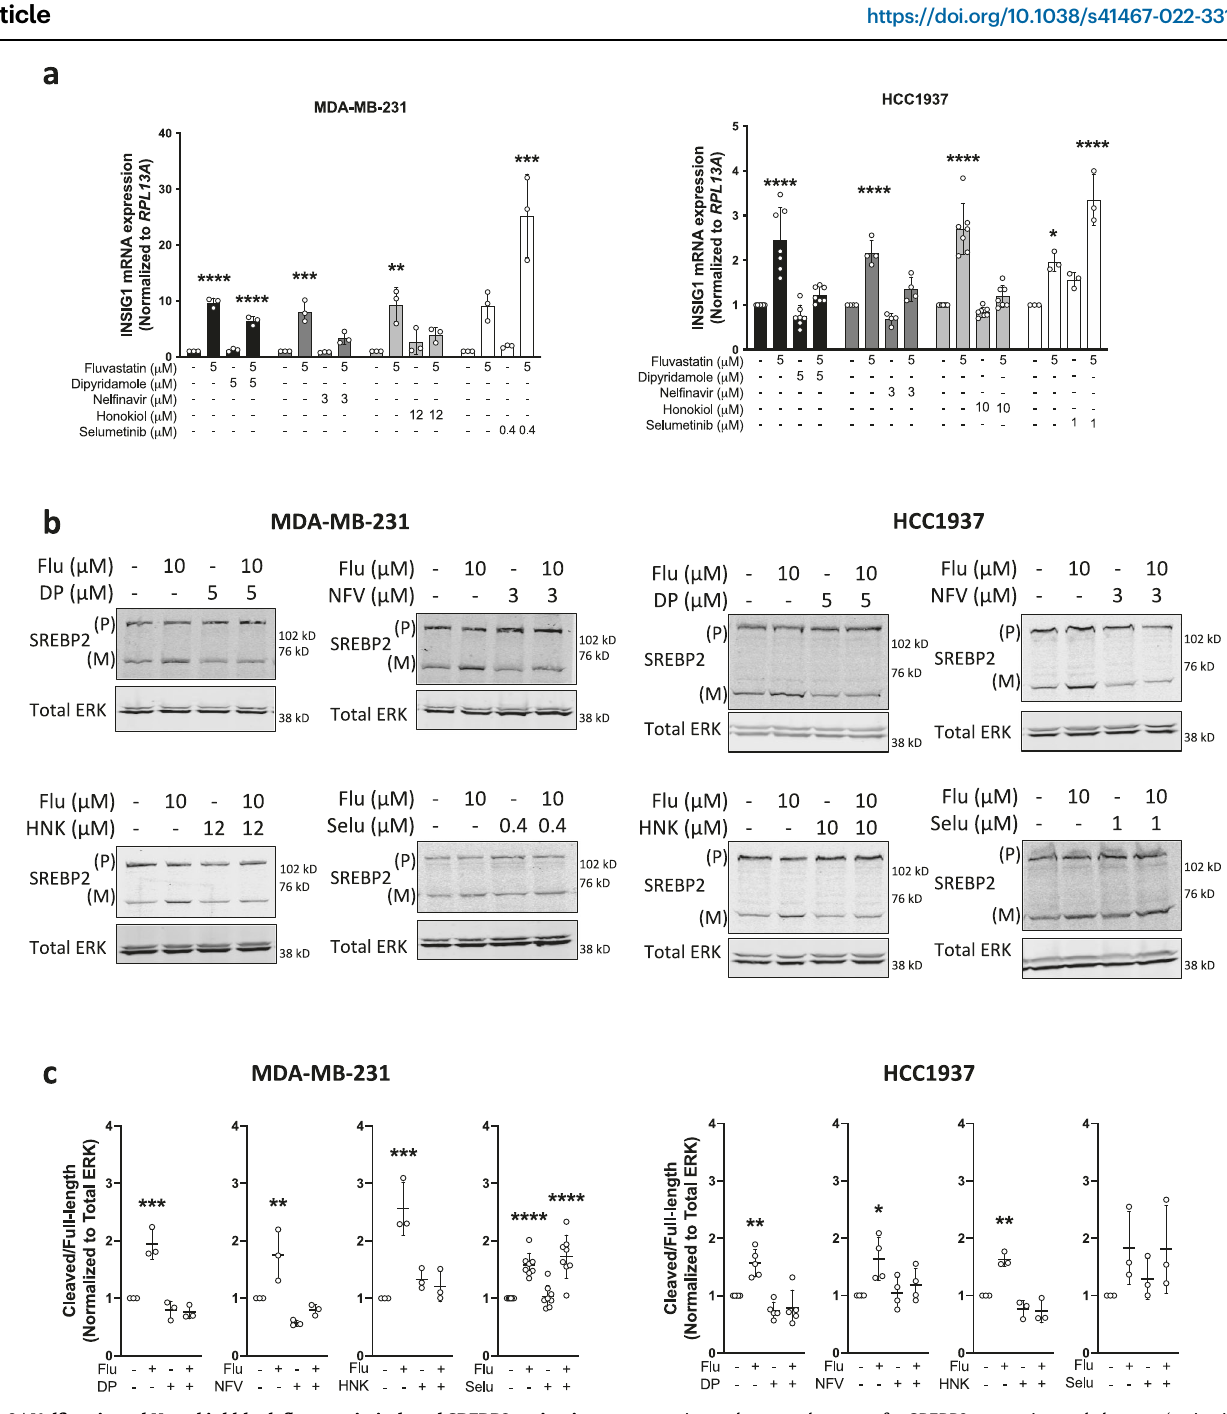
proteinwasharvestedtoassayforSREBP2expressionand cleavage(activation)by immunoblotting. (P) represents precursor, full-length SREBP2, and (M) represents mature, cleaved SREBP2. Total ERK was assayed as a protein loading control. N =3 – 8biologicallyindependentexperiements,therepresentativeimageisshown. c SREBP2 cleavage (cleaved/full-length) was quanti fi ed by densitometry and nor- malized to total ERK expression. Error bars represent the mean+/ − SD, n =3 – 8 biologically independent samples, * p <0.05, ** p <0.01, *** p <0.001, **** p <0.0001 (one-way ANOVA with Bonferroni ’ s multiple comparisons test, where each group was compared to the solvent controls group within its experiment). Source data are provided as source data fi